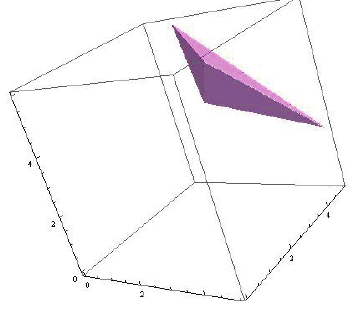
Fig. 1. Solution set space of